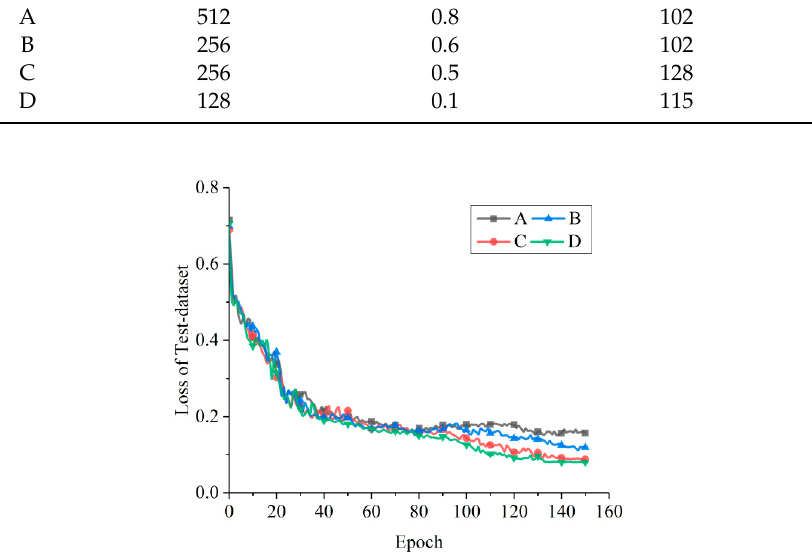
Figure 6. Different combinations of the Fully Connected layer (FC) node number and dropout rate have different convergence speeds in the test data set.